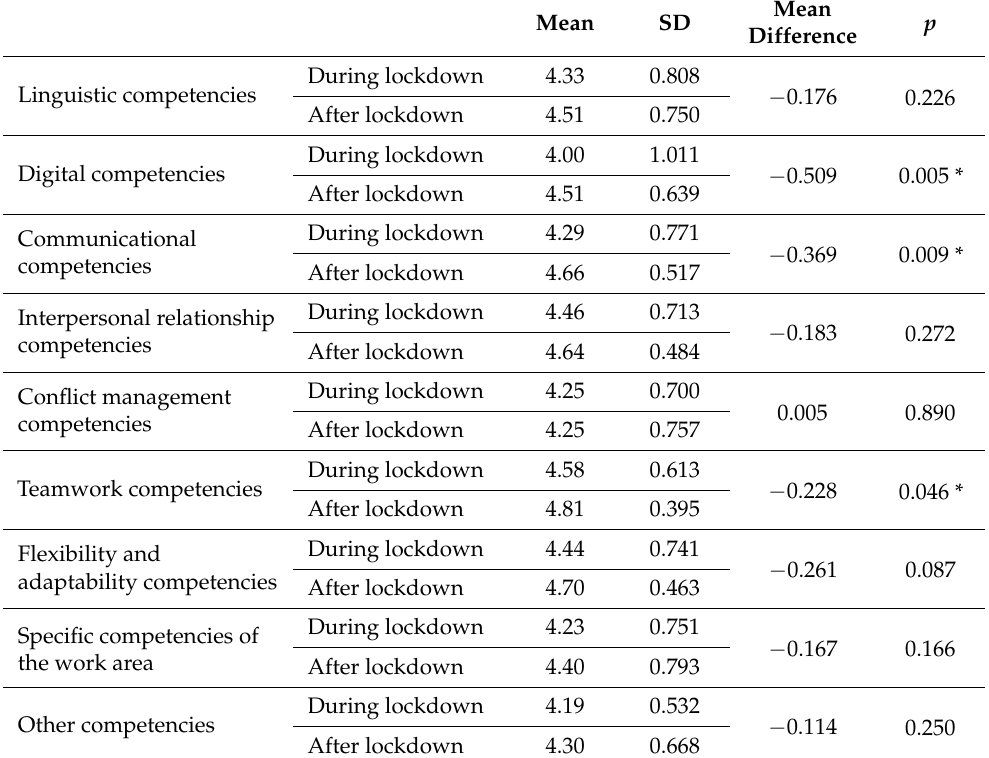
Table 2. Differences in the self-evaluation of competences—during and after